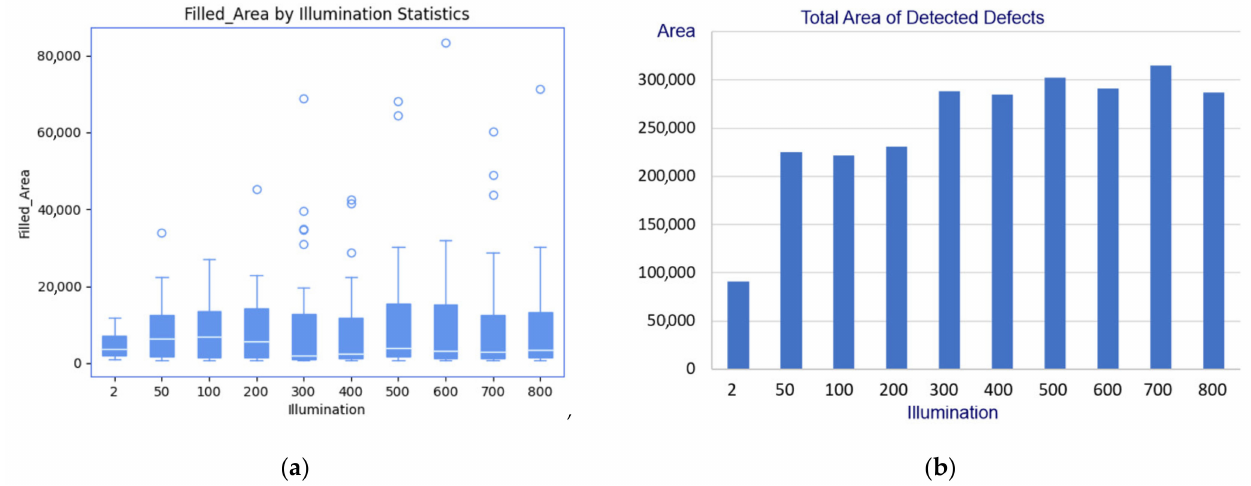
Figure 8. Diagram of damage fragments area distribution ( a ) and their total area ( b ) at various lighting; circles—values exceeding 1.5 ·